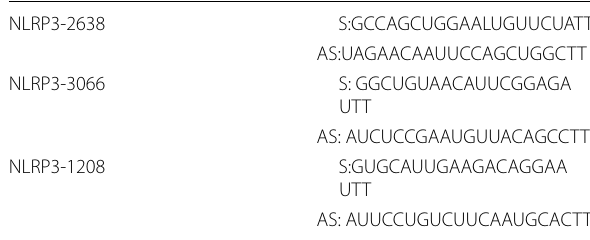
Pyroptotic cell death assay‑lactate dehydrogenase (LDH) release assay